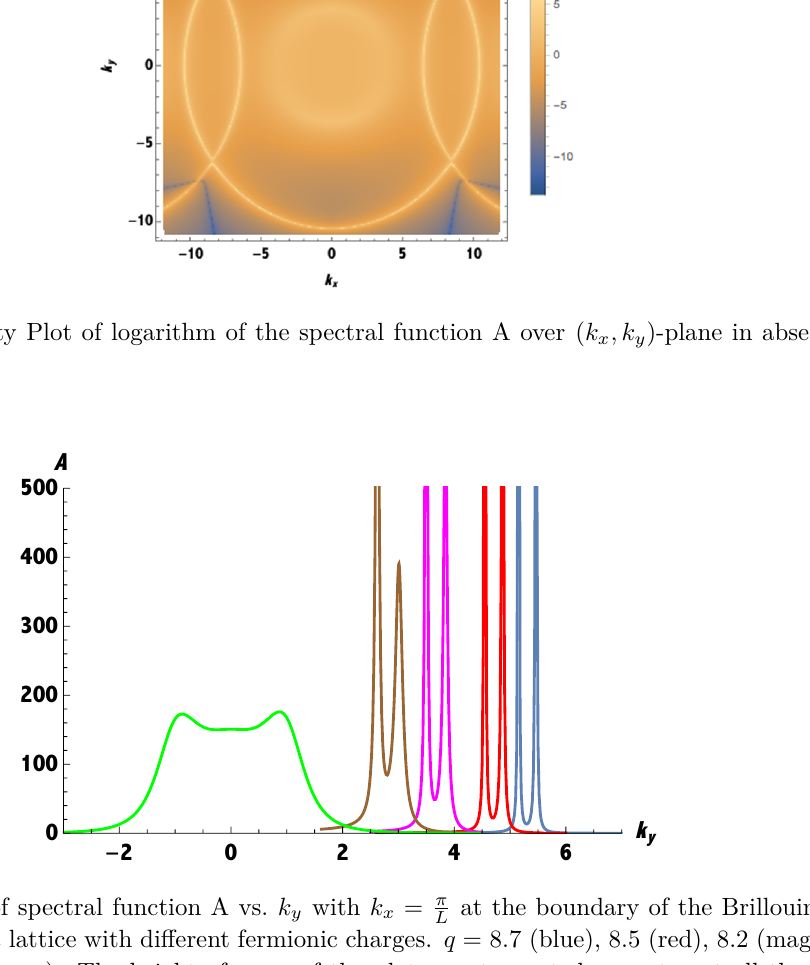
at the boundary of the Brillouin zone L